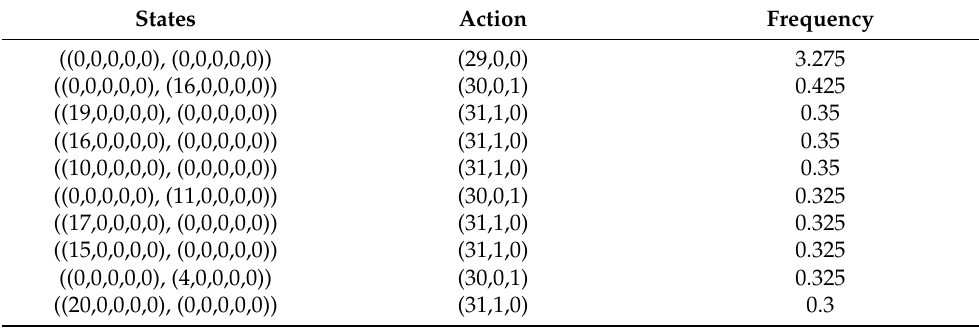
Table 2. The most frequent (state, action) pairs for the DQN scheduler.